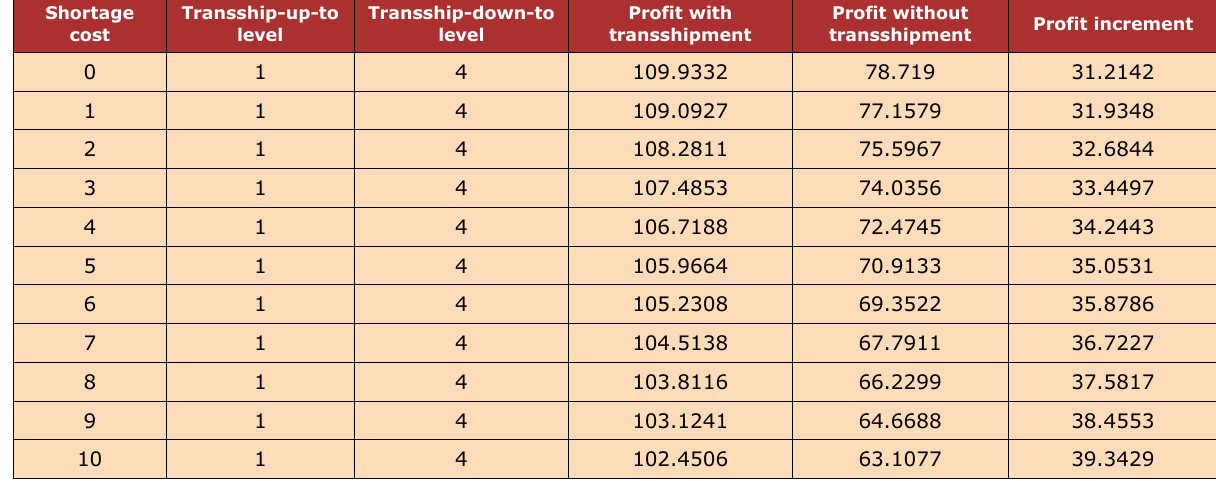
Table 1. Relation between profit, transshipment and shortage cost